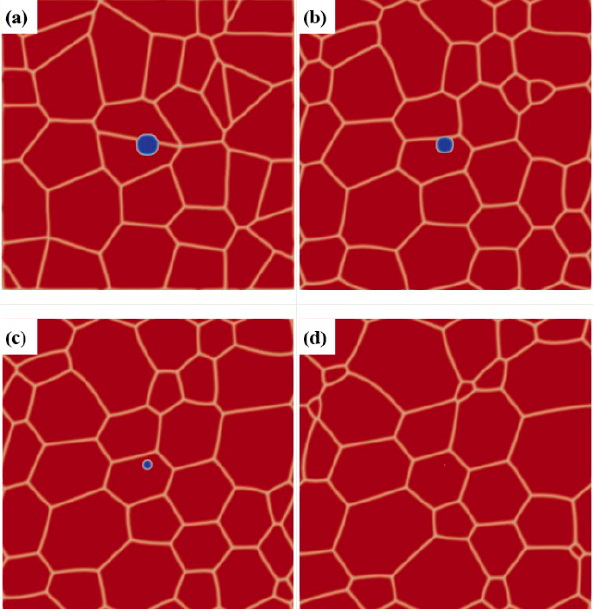
Figure 8. Evolution of void morphology with simulation time (36 grains): ( a ) time = 0; ( b ) time = 25; ( c ) time = 50; (d) time = 75. Since the phase-field method uses dimensionless parameters, the simulation results in Figure 8 are also dimensionless.